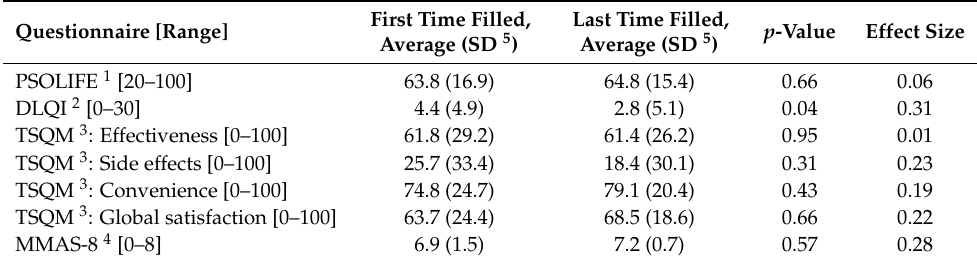
Table 2. Average and SD of the first and last PSOLIFE, DLQI, TSQM, and MMAS-8 answered questionnaires.